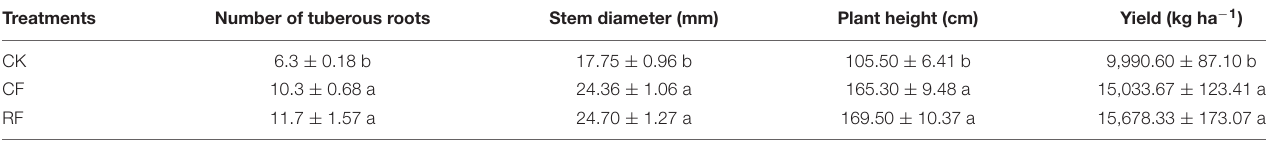
TABLE 2 | The yield and its parameters of cassava under different fertilizations. Treatments Number of tuberous roots